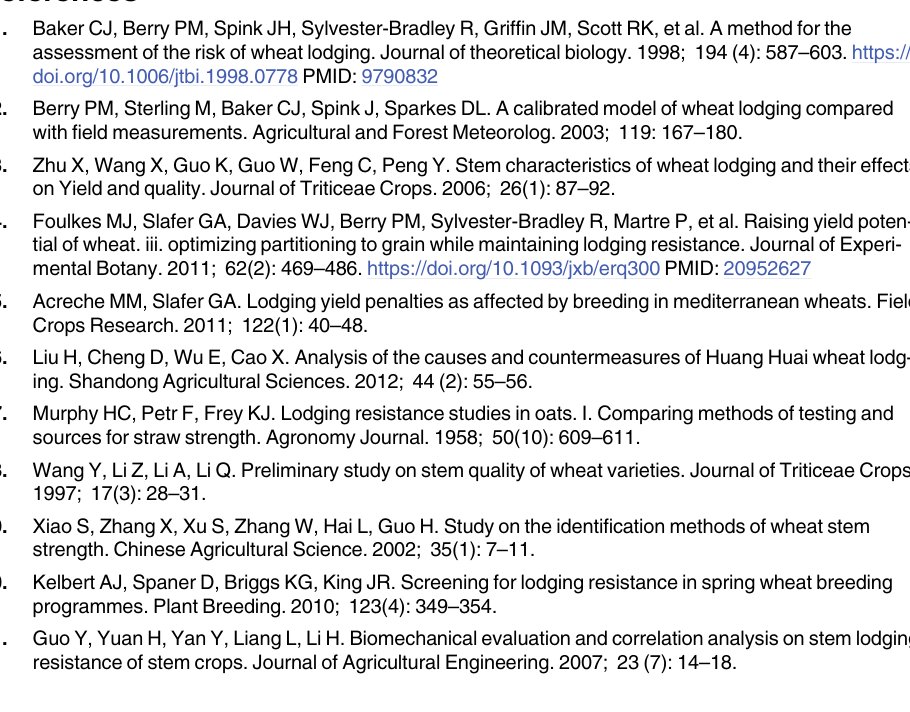
S6 File. Fig 5 Data3. S7 File. Table 2 Data. S8 File. Fig 7